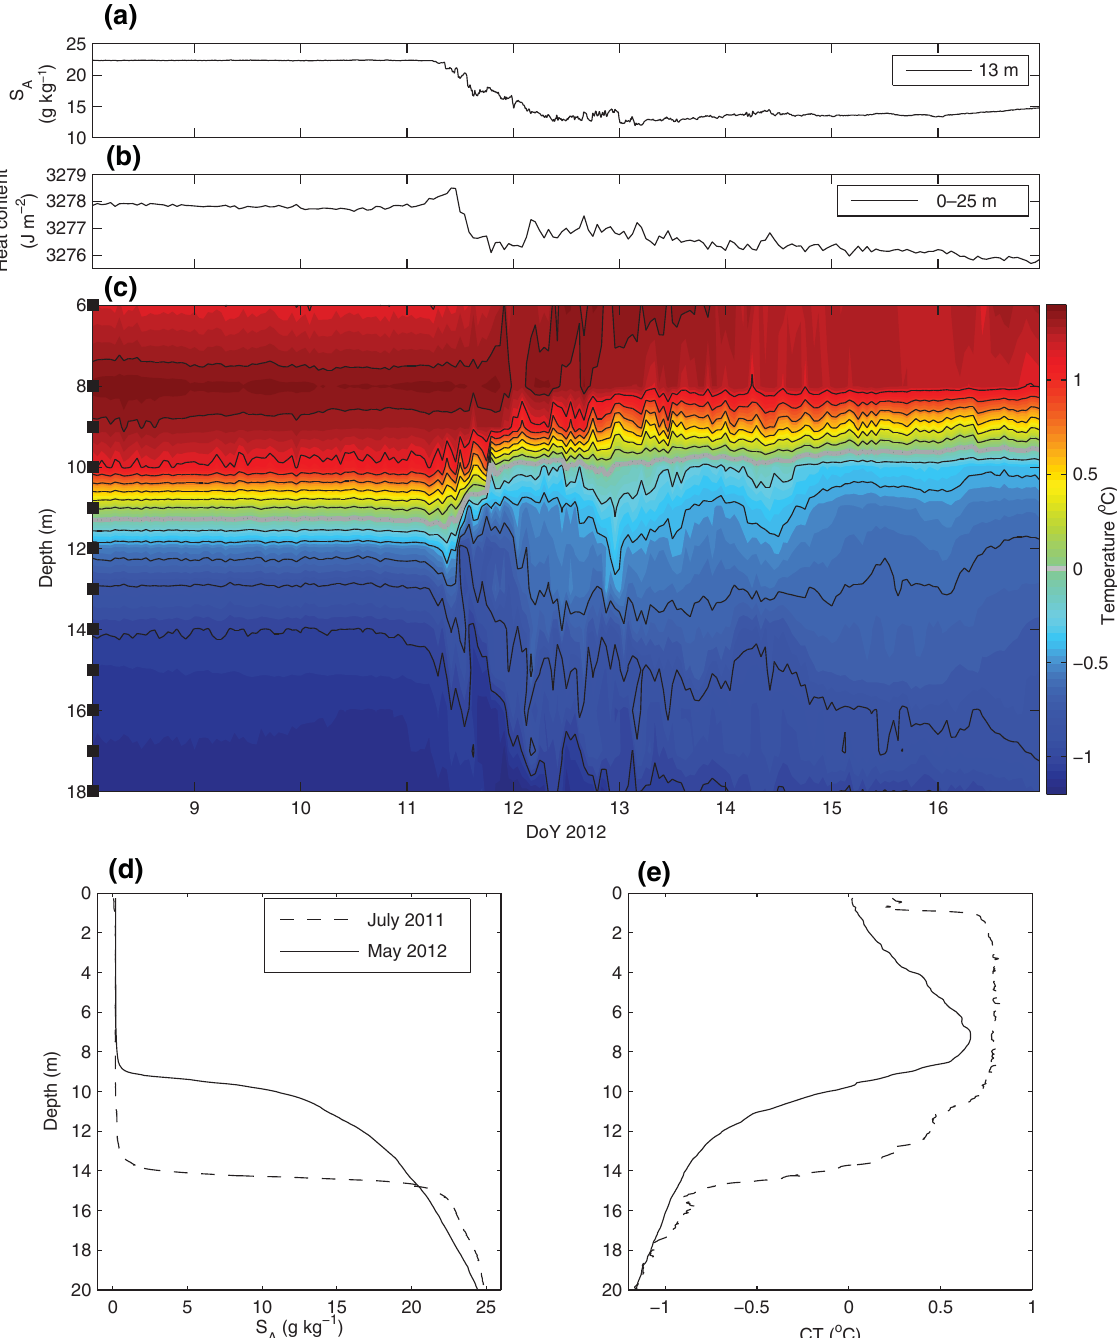
Figure 8. January 2012 MEL halocline mixing event. Time series of (a) salinity at 13m depth, (b) heat content between 0 and 25m, and (c) temperature between 6 and 18m depth. The isotherm increment is 0.2 ◦ C, and the 0 ◦ C isotherm (grey) is highlighted as a proxy for the bottom of the epishelf lake. Black squares on y axis indicate the depths of thermistors. Profiles of (d) salinity and (e) temperature from field campaigns 6 months before (July 2011) and 4 months after (May 2012) the mixing event show the permanent change in the structure of the halocline (note that some of the change in the depth of the halocline is due to seasonal